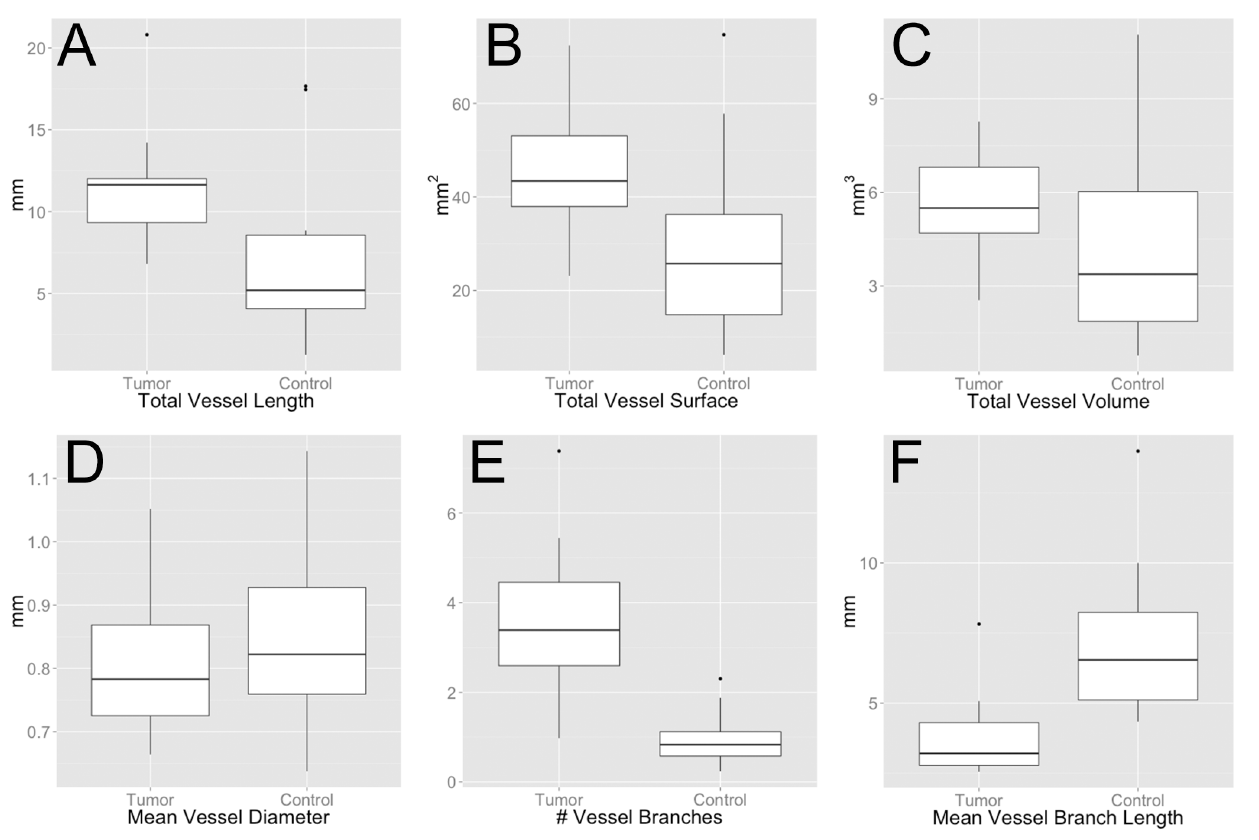
Figure 3. Box plots of assessed parameters within tumor VOI and control VOI in the contralateral white matter. Total vessel length (A) (p , 0.064), total vessel surface (B) (p , 0.035), vessel volume (C) (p , 0.078) and number of vessel branches (E) (p , 0.001) per cubic centimeter are increased within the tumor compared to contralateral white matter. In contrast mean vessel diameters (D) (p , 0.064) and average branch length of vessels (F) (p , 0.001) are decreased in the